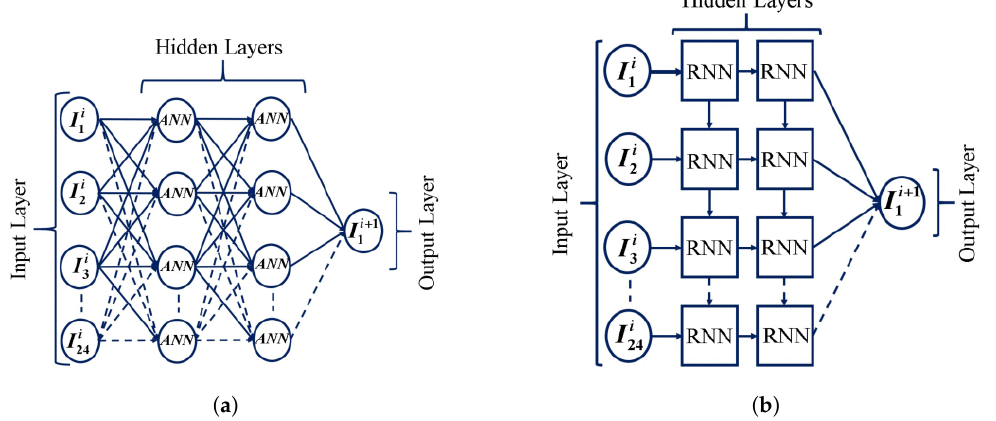
Figure 4. Employing artificial neural network (ANN) and recurrent neural network (RNN) method- ologies to forecast plug-in hybrid electric vehicle (PHEV) demand. ( a ) The PHEV load forecasting by ANN method. ( b ) The PHEV load forecasting by RNN method.